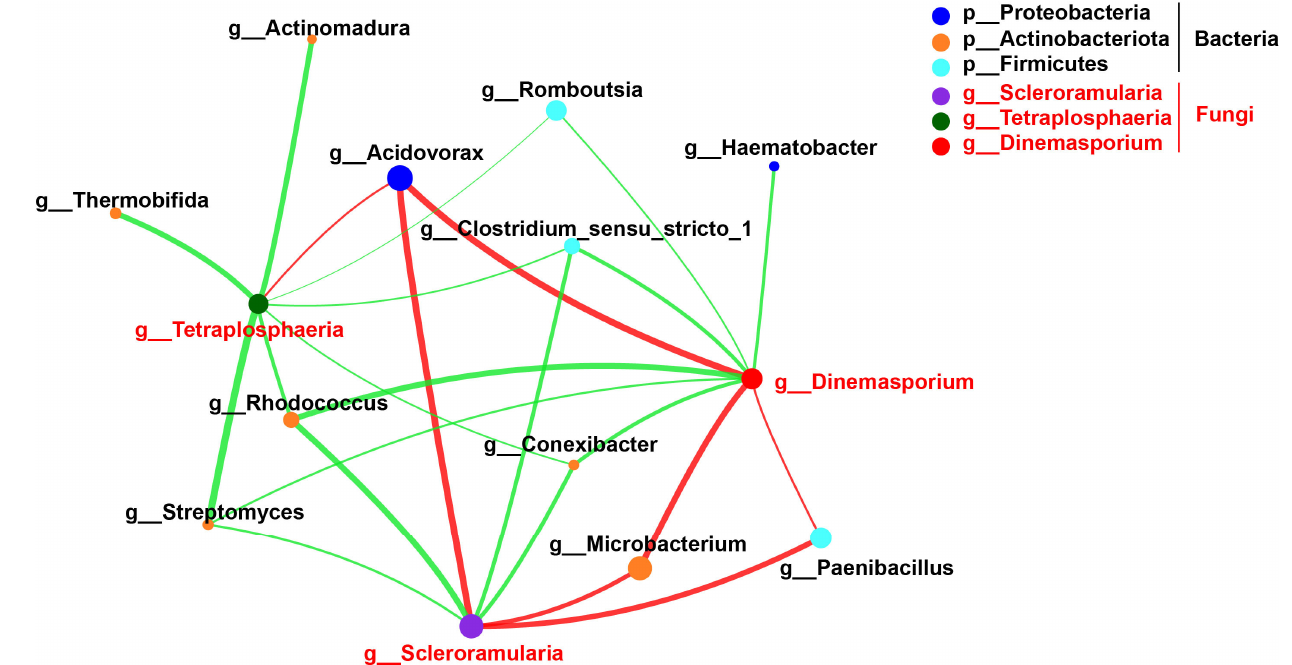
Figure 5. Correlation network analysis of significantly enriched bacterial and fungal genera. The Spearman coefficients that showed the significant enrichment of bacterial and fungal genera were also calculated to reflect the correlation between species, where the absolute value of the correlation coefficient ≥ 0.5, with p < 0.05. The sizes of the nodes in Figure 5 indicate the abundances of species, and different colors indicate different species; the color of the connecting lines indicates a positive and negative correlation, where red indicates a positive correlation, green indicates a negative correlation, and the thickness of the lines indicates the magnitude of the correlation coefficient. The thicker the line, the higher the correlation between species; the more lines, the closer the connection between the nodes (p—phylum; g—genus).